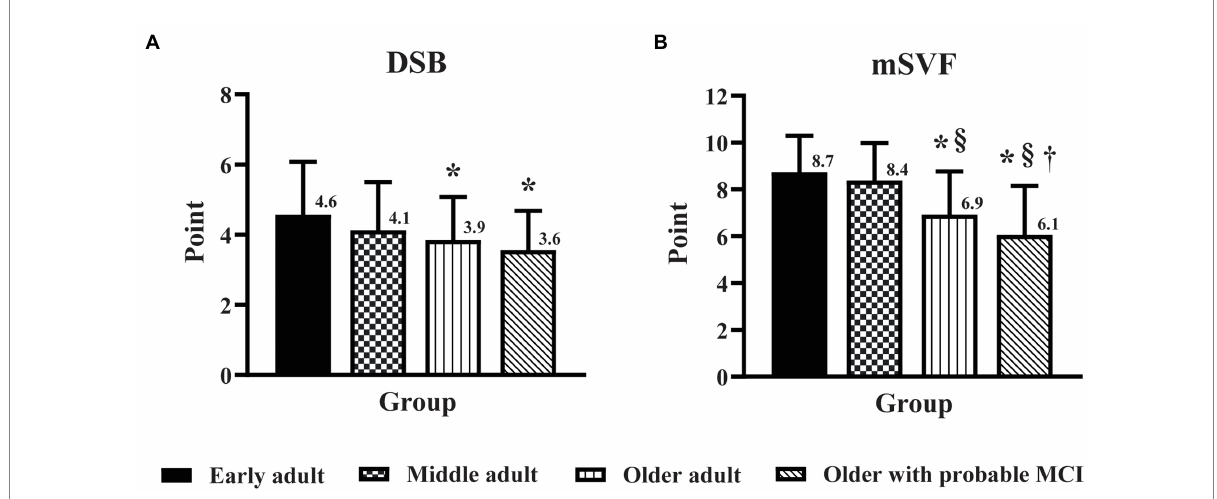
FIGURE 2 The influence of education level on the effect of age and mild cognitive impairment (MCI) on the domains of executive function. Executive function was assessed by the digit span backward task (A) and the modified switching verbal fluency test (B) in early adult, middle adult, older adult, and older with probable MCI patients with a high education level. DSB, digit span backward task; mSVF, modified switching verbal fluency test; MCI, mild cognitive impairment. * p < 0.05 vs. early adult group; § p < 0.05 vs. middle adult group; † p < 0.05 vs. older adult group.